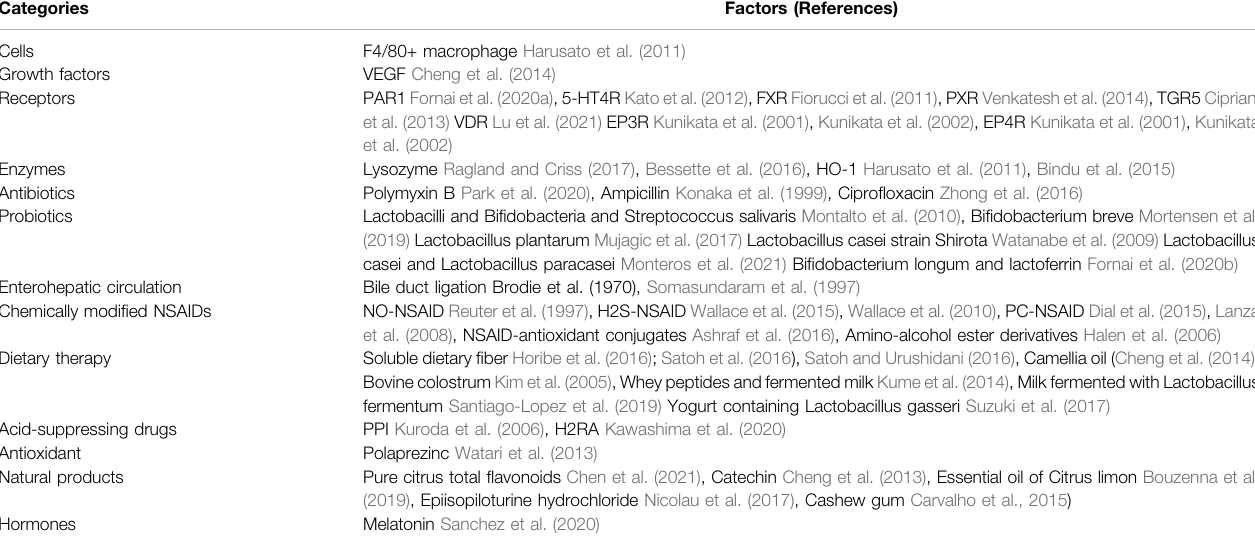
TABLE 3 | Prevention of NSAID-associated small intestinal